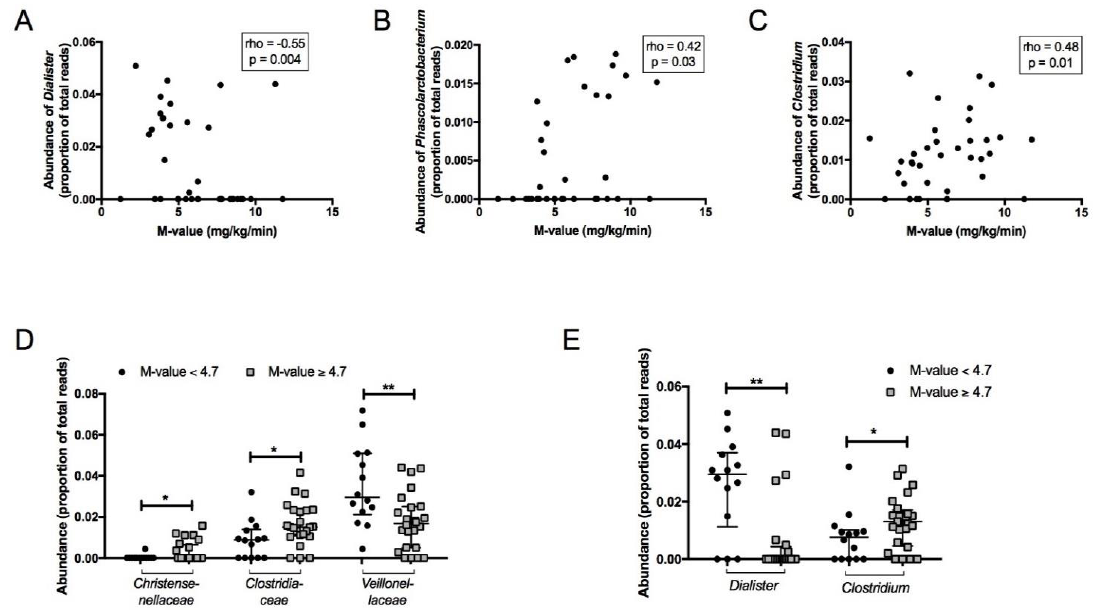
Figure 2. ( A ) The Spearman correlation between insulin sensitivity (M-value) and Dialister . ( B ) Spearman correlation between insulin sensitivity (M-value) and Phascolarctobacterium. ( C ) Spearman correlation between insulin sensitivity (M-value) and Clostridium . ( D,E ) Differences in faecal microbiota between insulin resistant (M < 4.7 mg/kg/min) and insulin sensitive (M ≥ 4.7 mg/kg/min) groups at family ( D ) and genus ( E ) levels.